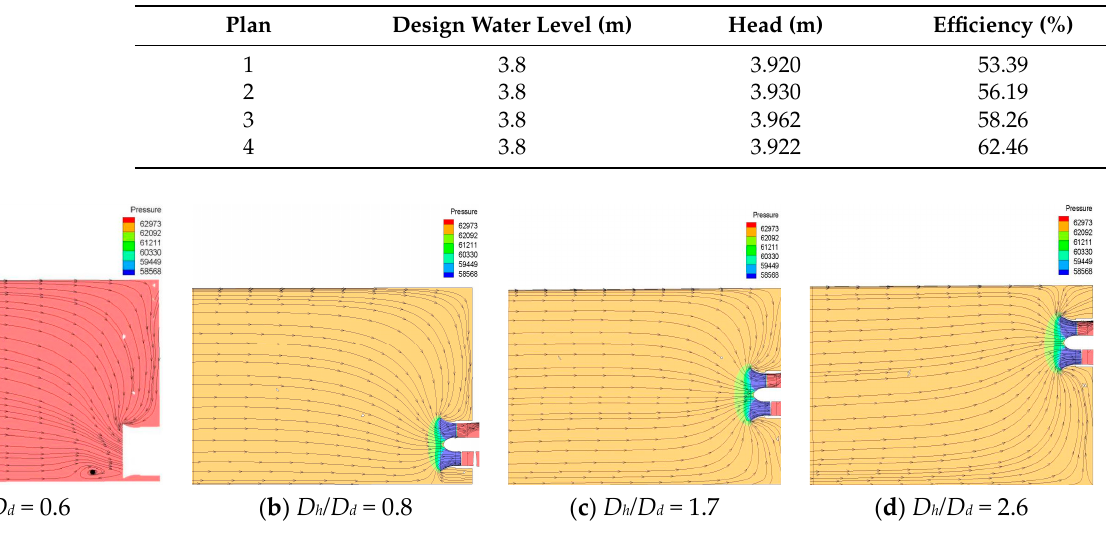
Figure 8. Suction sump pressure and flow line diagram (section 1 - 1, unit:pa).